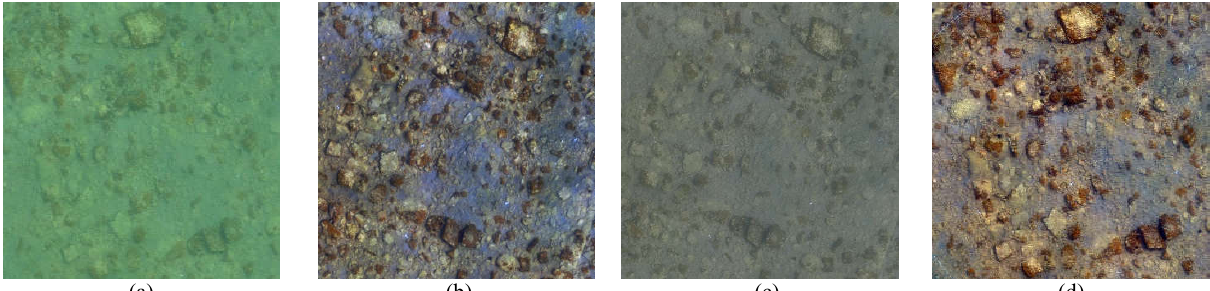
Figure 7. The orthoimage of the shallow dataset created by using the original images (a), by correcting the (a) using the CLAHE based algorithm (b), by correcting the (a) using the algorithm of Bianco et al., (c), (2015) and by correcting the (a) using the Adobe